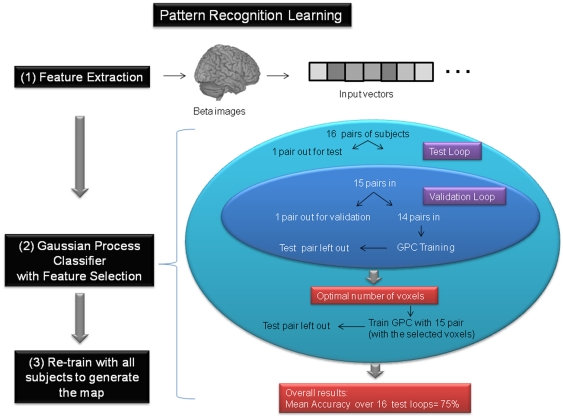
Summary of pattern recognition analyses.(1) Feature Extraction: the information from the beta images were transformed into an input vector. (2) Nested leave one out (LOO) Approach. We employed a nested (3-way) cross-validation, where we first excluded one matched pair of subjects to comprise the test set (test loop in light blue). We then performed a second split (validation loop in dark blue), where we removed 5000 voxels each iteration and repeatedly repartitioned the remaining 15 subject pairs into a validation set (1 pair) and training set (14 pairs) to compute the mean accuracy on the validation set. This procedure (removing voxels and computing mean accuracy) was repeated until all voxels were removed. We then selected the number of voxels that produced maximal accuracy on the validation set before applying it to the test set. The final accuracy was the mean accuracy over all test subjects (outer test loop in light blue). (3) We then generated a map training the GPC with all subjects and removing voxels until we obtained the mean number of voxels.